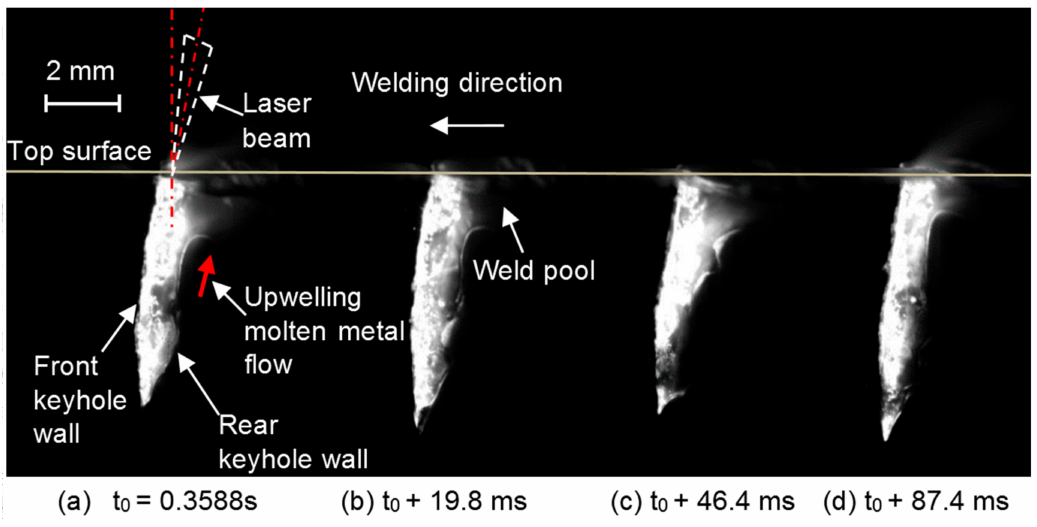
Figure 10. Images of the longitudinal keyhole and vapor plume in the forward welding (p = 10 kW, v = 1.8 m/min, ∆ = +10